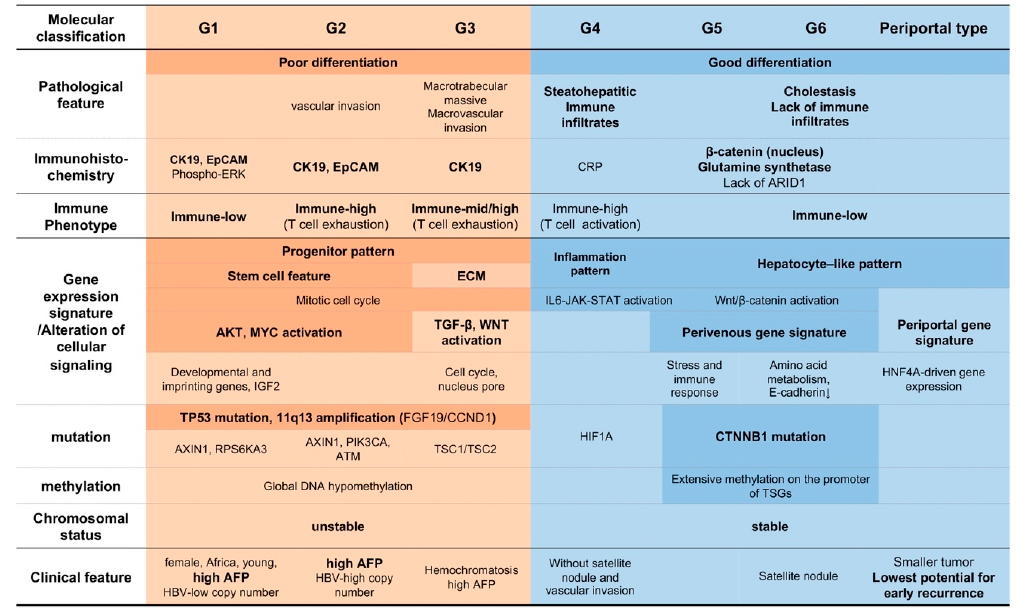
Figure 1. Molecular classification, clinicopathological characteristics, and immune phenotype of human hepatocellular carcinoma (HCC). Subclasses shown as G1–G6 were described by Boyault et al. [9]. The associations between the molecular subclass and pathological characteristics were reported by Calderaro et al. [32]. The classification shown as “periportal type” was described by Desert et al. [33]. Immune phenotype in this figure (immune-high, -med, and -low) was proposed by Kurebayashi et al. [34]. The bold denotes the representative findings of molecular, clinical, and pathological features. ECM: extracellular matrix. HNF4A: hepatocyte nuclear factor 4A. HIF1A: hypoxia inducible factor A. TSGs: tumor suppressor genes.